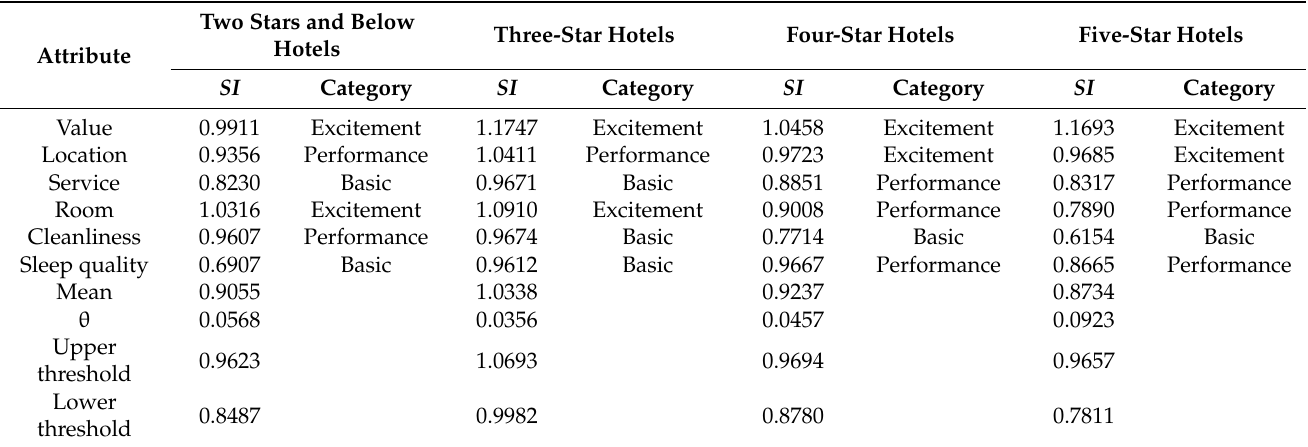
Table 10. The three Kano categories of six attributes concerning four hotel star